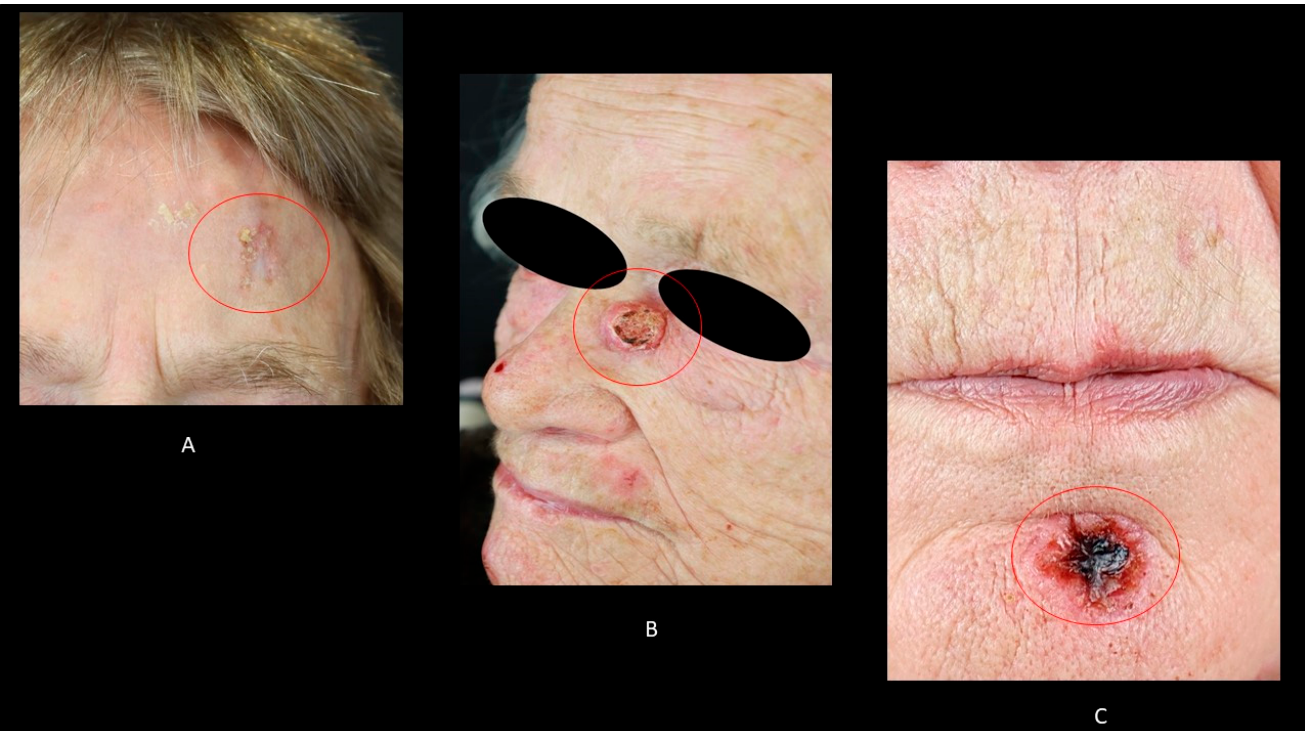
Figure 1. ( A ): Bowen’s disease of the forehead; ( B ): keratoacanthoma of the nose; ( C ): ulcerated squamous cell carcinoma on the chin.